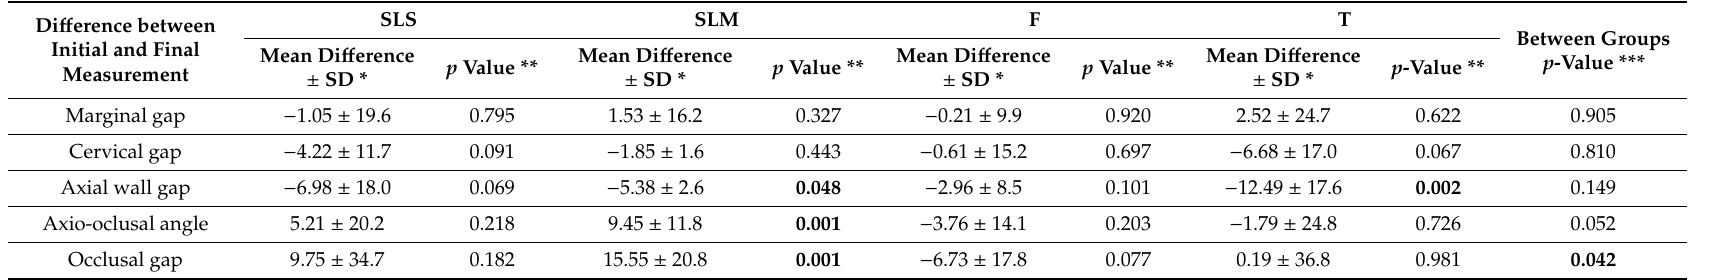
Table 2. Mean di ff erence between initial and final